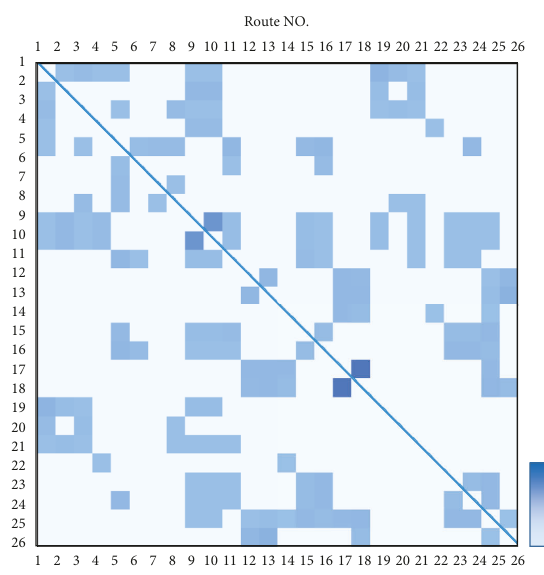
Figure 3: The demonstration of the count of shared stops of each pair of bus routes. Table 2: Results of proposed models.